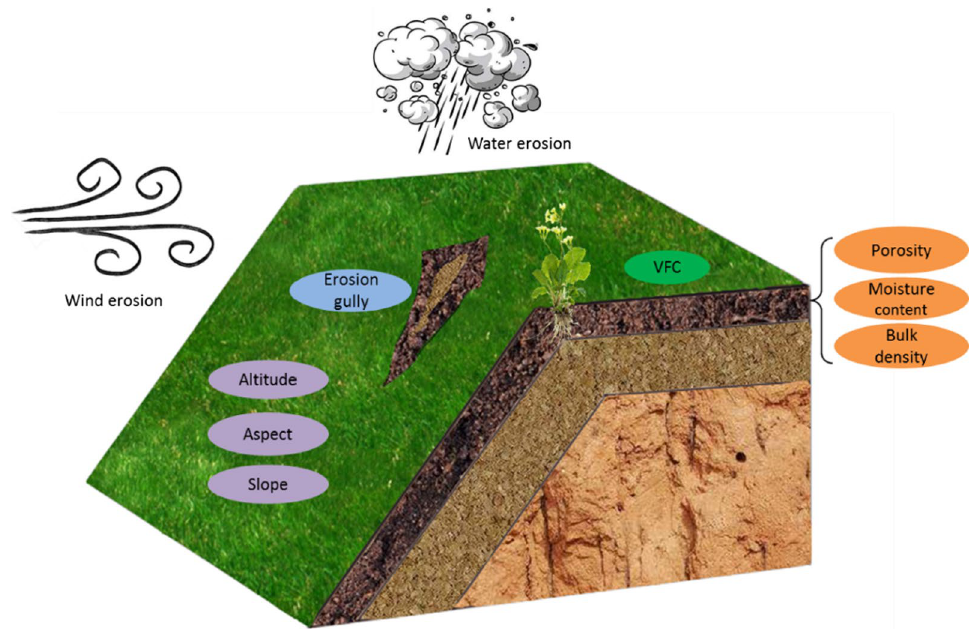
Fig. 3 Potential impact of wind and soil erosion on coal mine dumps under natural